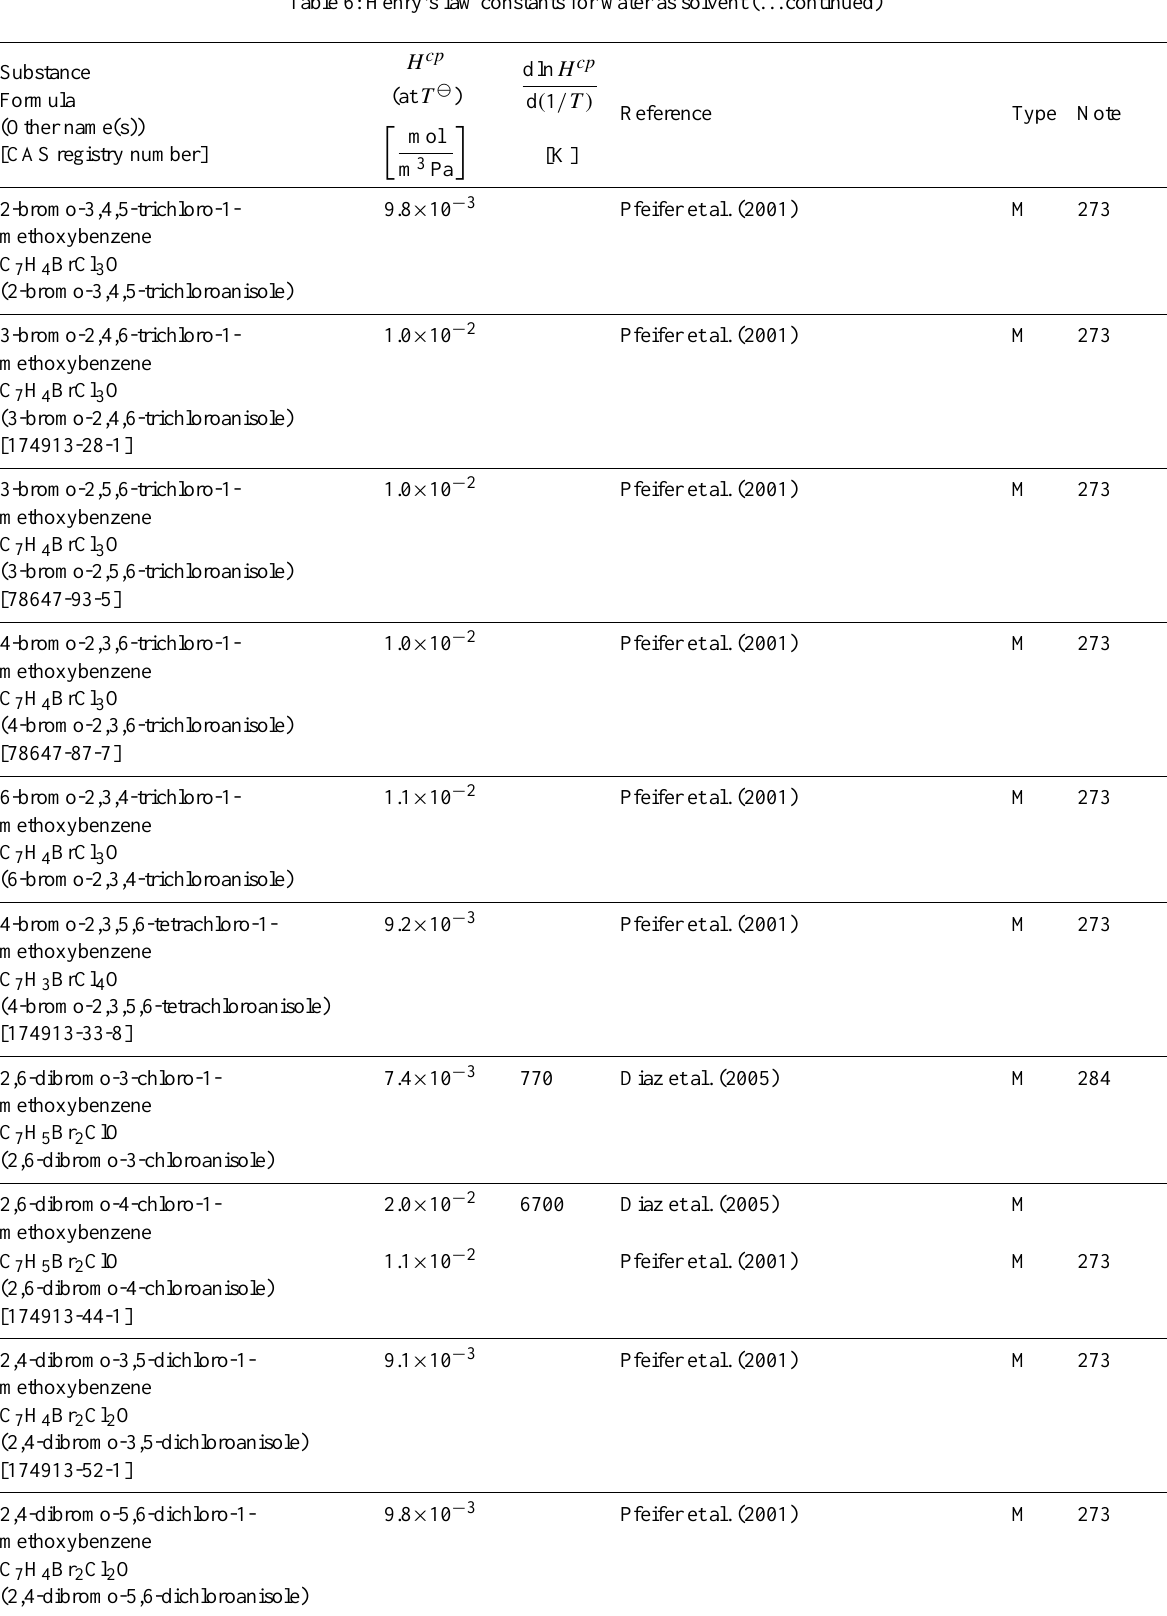
Table 6: Henry’s law constants for water as solvent